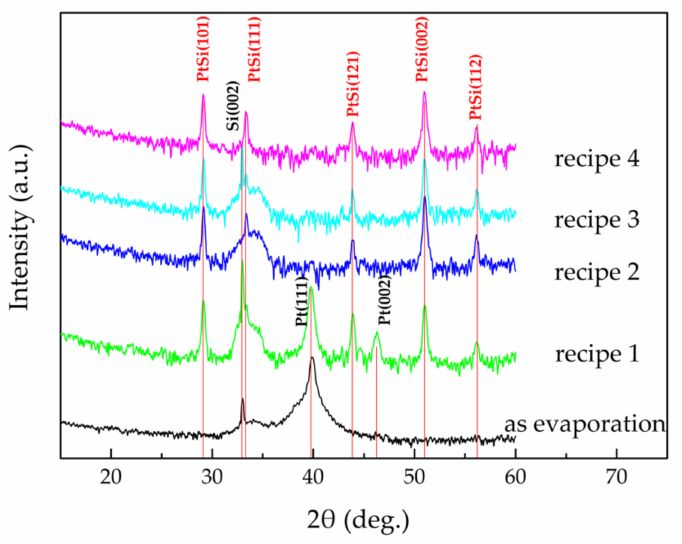
Figure 6. XRD spectra of the Pt/Si films before and after annealing in different conditions referring to the recipes in Table 1.